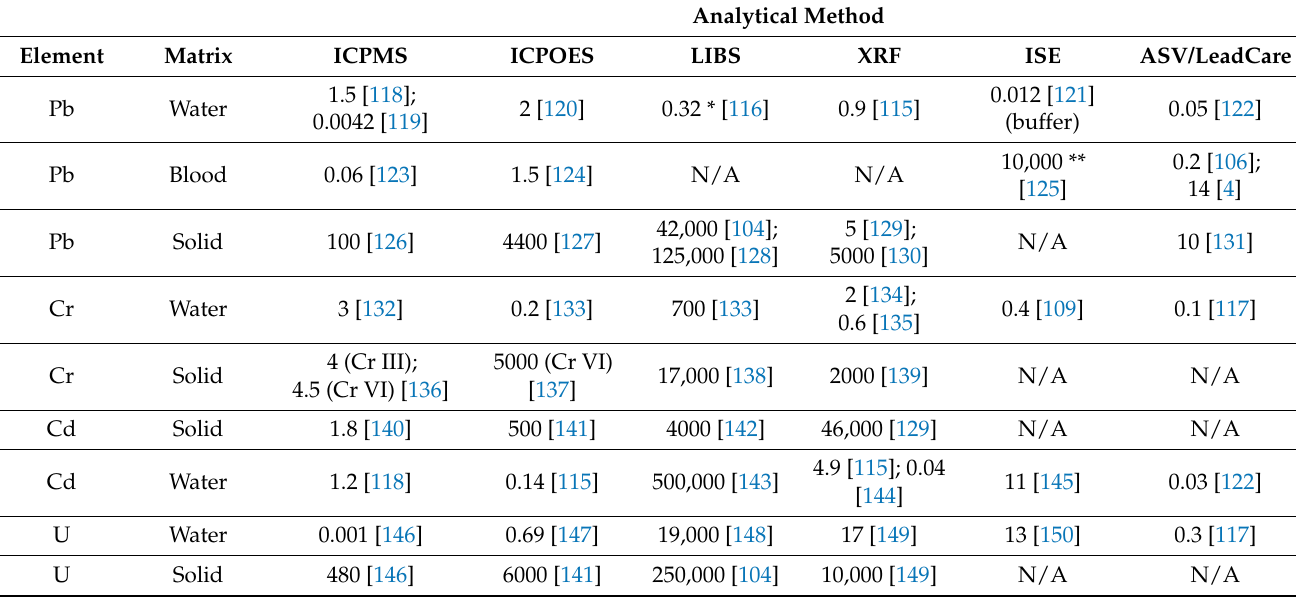
Table 1. Comparison of detection limits reported as ppb (ng/mL or ng/g) for multiple instruments in either solid, water, or blood